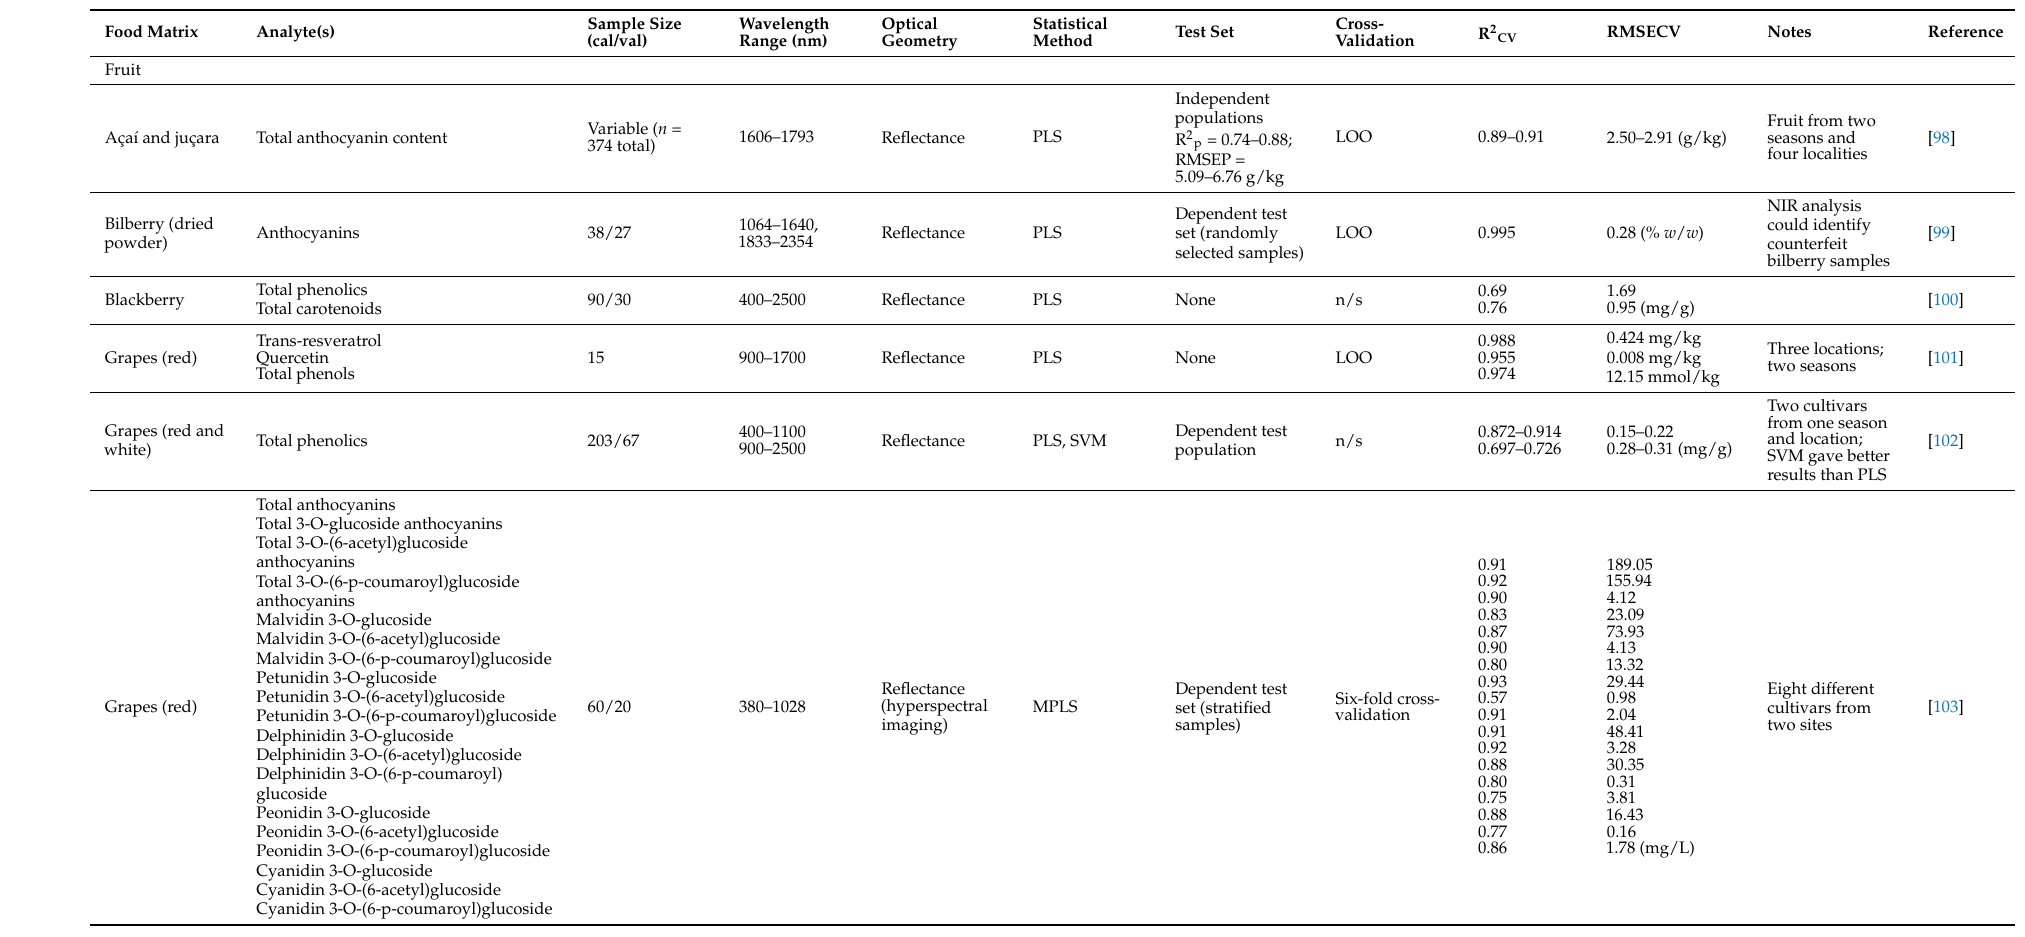
Table 2. Studies reporting the use of near-infrared spectroscopy for the quantification of bioactive compounds in food products